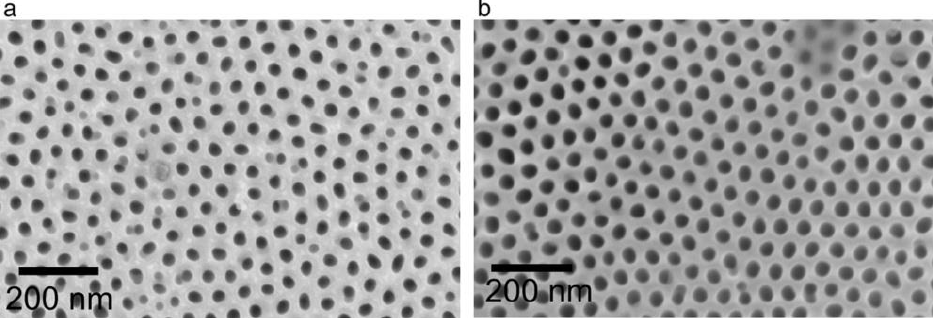
Figure 7. Different degrees of hexagonal pore ordering achieved in a two-step anodizing process using untreated 99.5% Al sheets ( a ) and the same sheets prepared by thermal treatment at 500 °C for 3 days ( b ). Reproduced with permission from [95]. Copyright 2008 Elsevier.